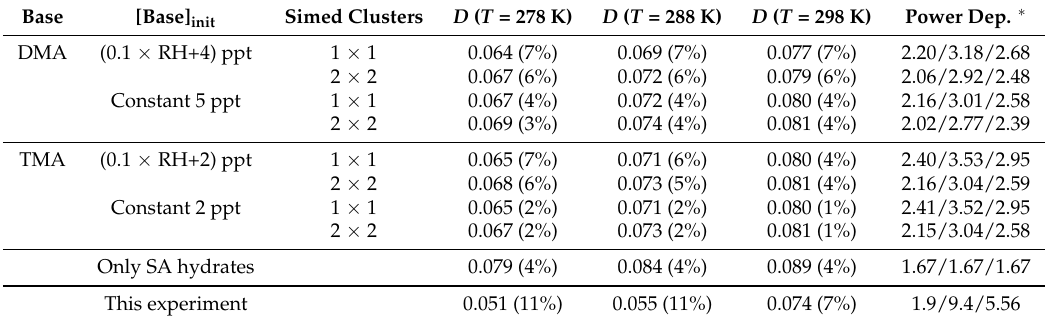
Table 1. Summary of simulated and experimental averages (unweighted over the range of RH that is covered at all three temperatures (15–70%)) of the effective H 2 SO 4 diffusion coefficients D (cm 2 · s − 1 ) with standard deviations in parenthesis for three temperatures 278, 288 and 298 K. The initial base concentration [base] init is set to be either RH-dependent according to Equation (3) or RH-independent, and the simulations consider clusters containing up to one acid and one base molecule (1 × 1) or two acid and two base molecules (2 × 2) as well as hydrates of the clusters. Power dependencies with respect to the temperature, obtained as linear fits to the data, are also